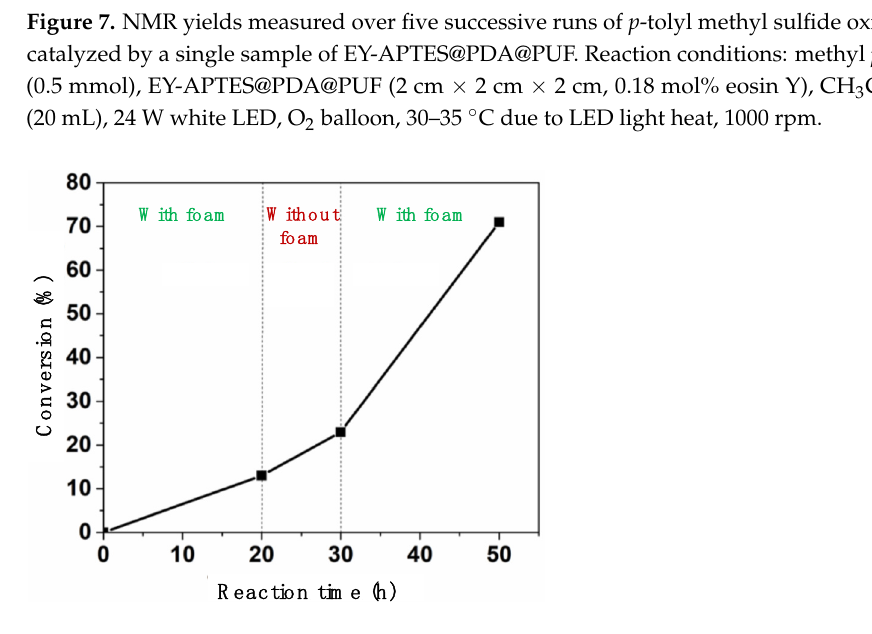
Figure 7. NMR yields measured over fi ve successive runs of p -tolyl methyl sul fi de oxidation photo- catalyzed by a single sample of EY-APTES@PDA@PUF. Reaction conditions: methyl p -tolyl sul fi de (0.5 mmol), EY-APTES@PDA@PUF (2 cm × 2 cm × 2 cm, 0.18 mol% eosin Y), CH 3 CN/H 2 O (4:1) (20 mL), 24 W white LED, O 2 balloon, 30–35 °C due to LED light heat, 1000 rpm.